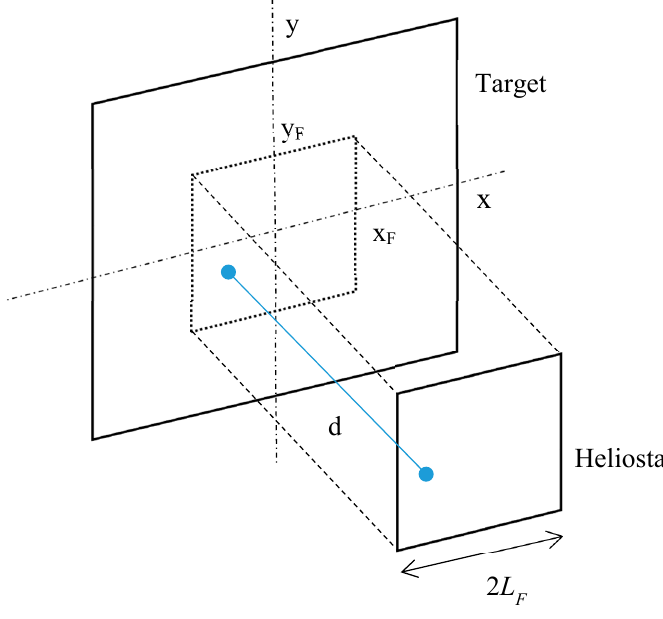
Figure 1. Scheme of the projection and enlargement from the heliostat to the target.